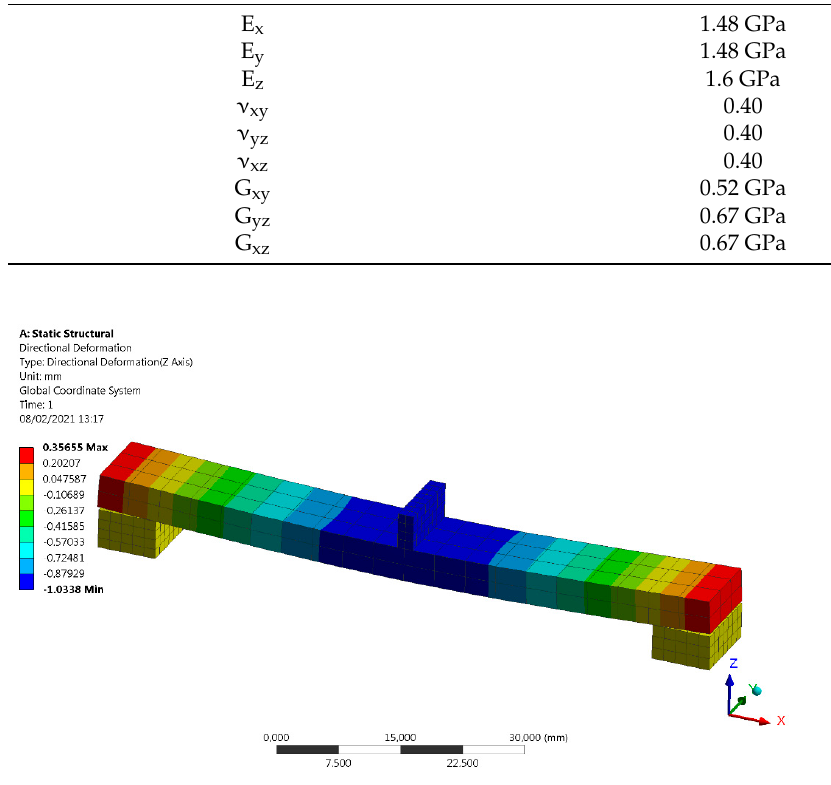
Figure 16. Finite elements simulation of flexural test part for a load of 18 N.